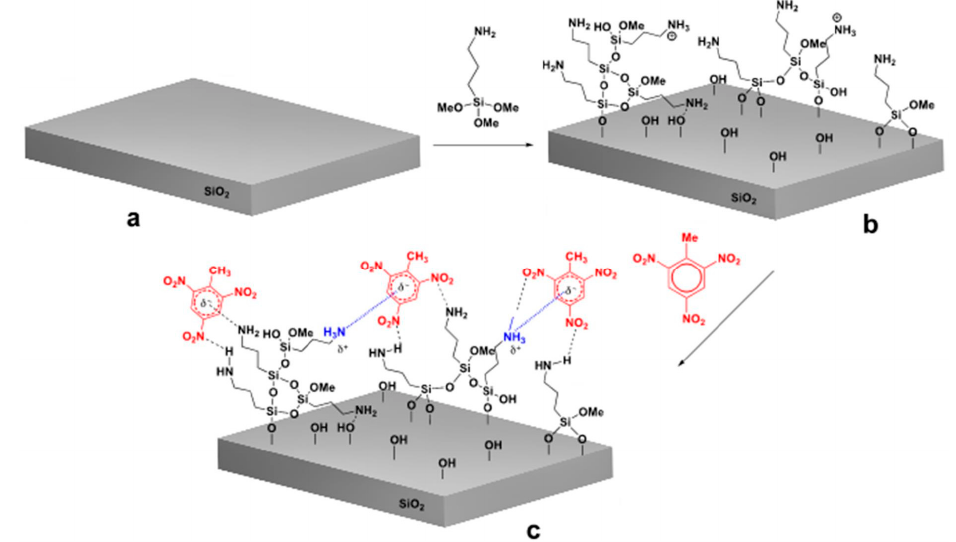
Figure 3. Modification of SiO 2 surface with APTMS molecules: ( a ) SiO 2 surface, ( b ) modified SiO 2 surface ( c ) interaction of analyte with the modified surface.